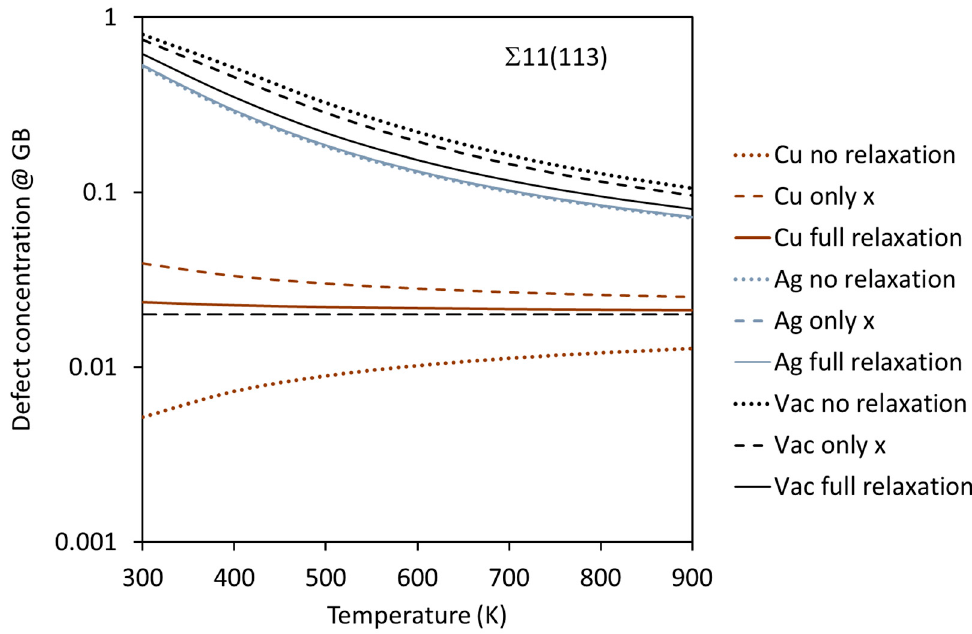
Figure 6. The defect concentration of point defects at the ∑ 11 ( 113 ) GB as a function of temperature. The bulk equilibrium concentration (0.02) is shown as a black, long-dashed line.